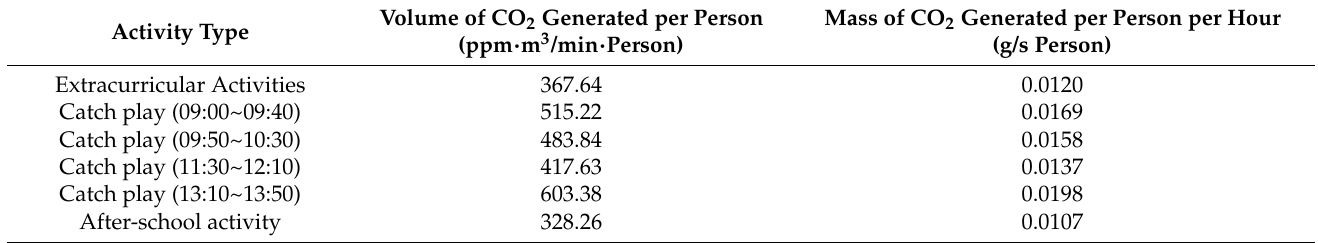
Table 7. CO 2 generation per person per hour for each physical activity in D Elementary